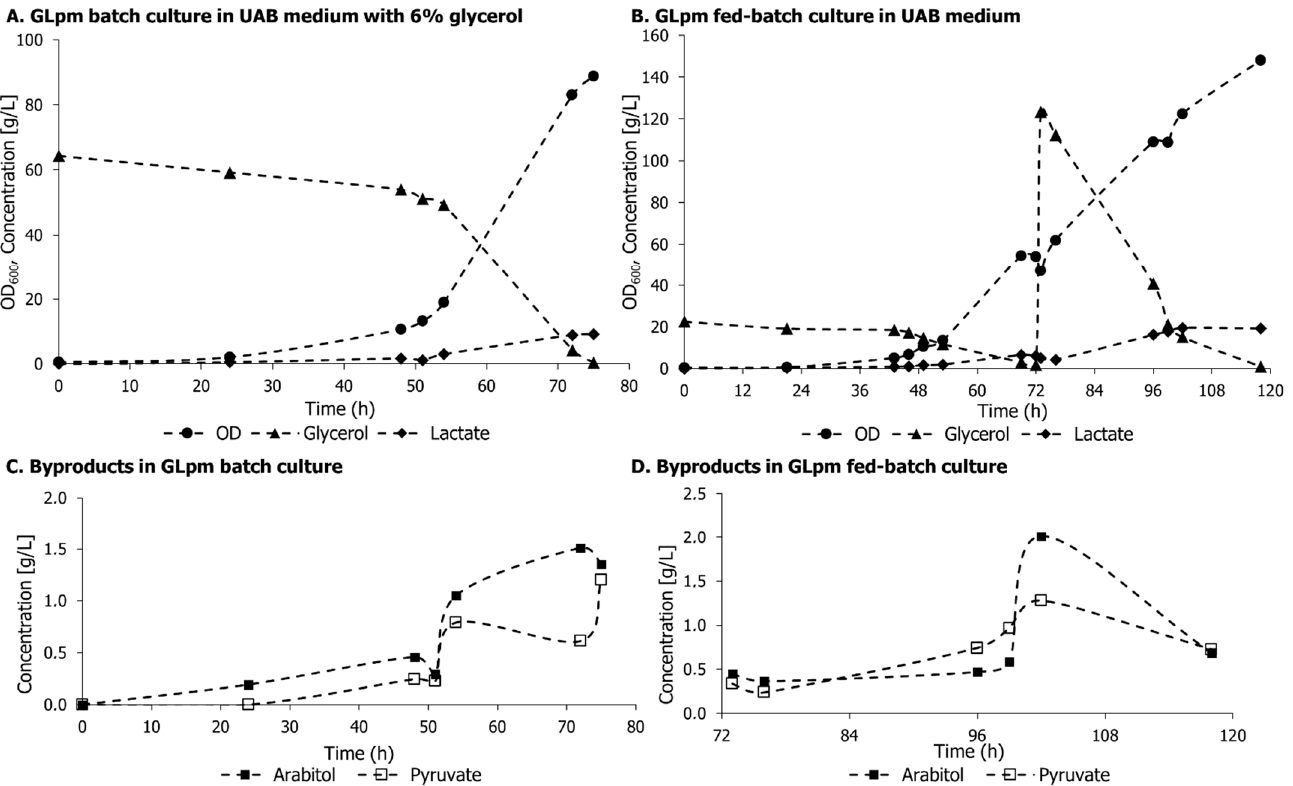
Figure 6. Growth curves, glycerol consumption, lactic acid production, and byproduct formation in GLpm batch ( A , C ) and fed-batch ( B , D ) cultivations in a 3 L bioreactor in UAB medium.